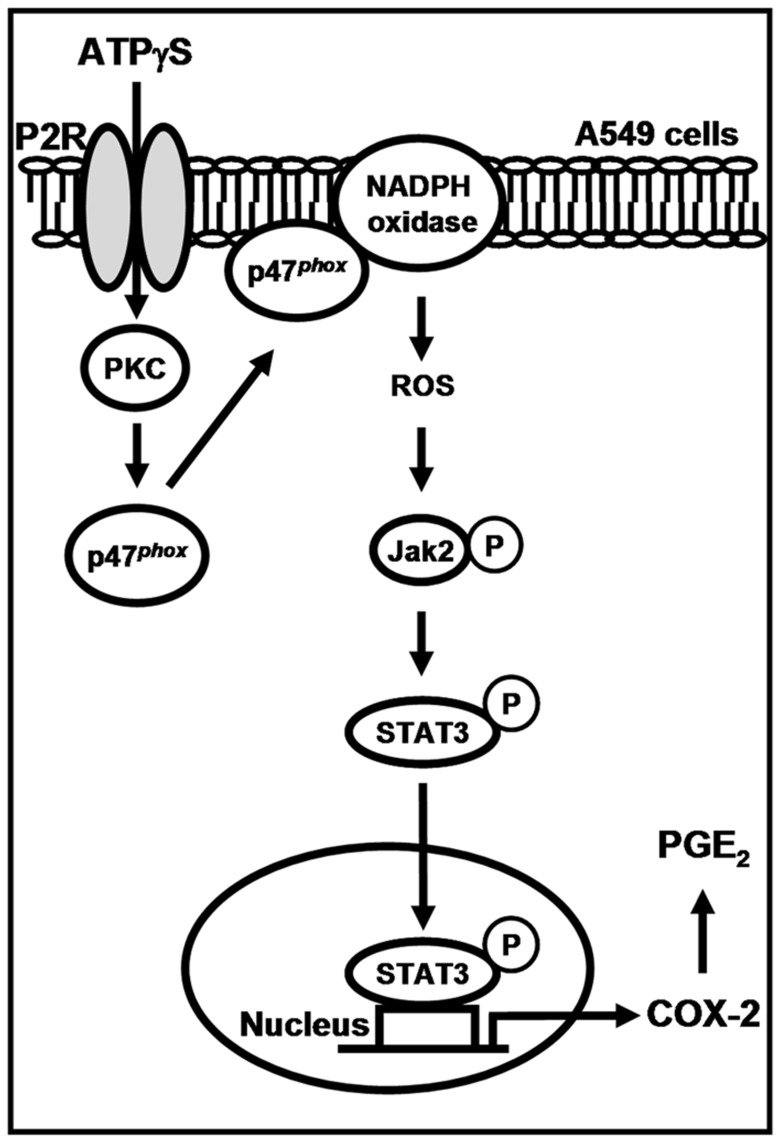
Schematic diagram illustrating the proposed signaling pathway involved in ATPγS-induced COX-2 expression and PGE2 generation in A549 cells.ATPγS activates the P2 receptor/PKC/NADPH oxidase pathway to enhance ROS generation, which in turn initiates the activation of Jak2 and STAT3, and ultimately induces COX-2-dependent PGE2 generation in A549 cells.